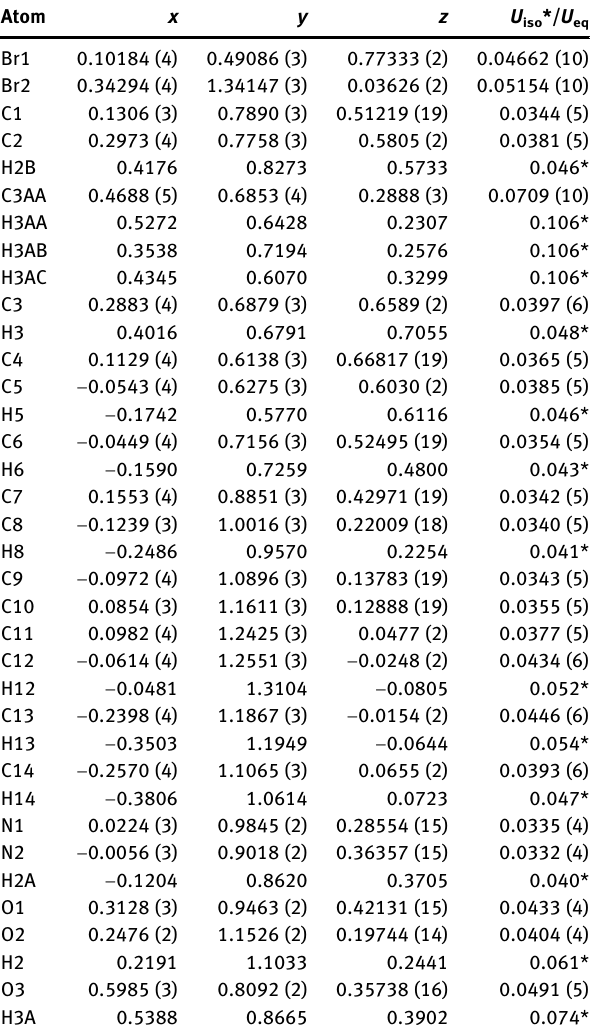
Table  : Fractional atomic coordinates and isotropic or equivalent isotropic displacement parameters (Å 